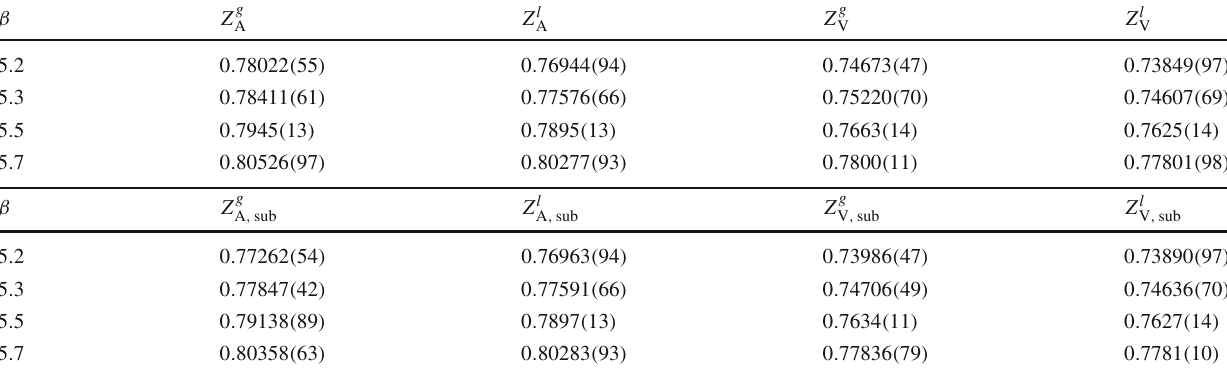
Table 4 Results for Z A , V , both g and l definitions, for N f = 2 non-perturbatively O ( a ) improved Wilson fermions and Wilson gauge action. The lower part of the table contains the same results after subtraction of the one-loop cutoff effects, cf. Eq.